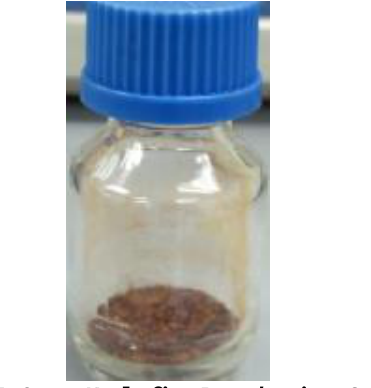
Figure 5. Gotu Kola fine Powder in a Sterile Container Media Preparation for MIC